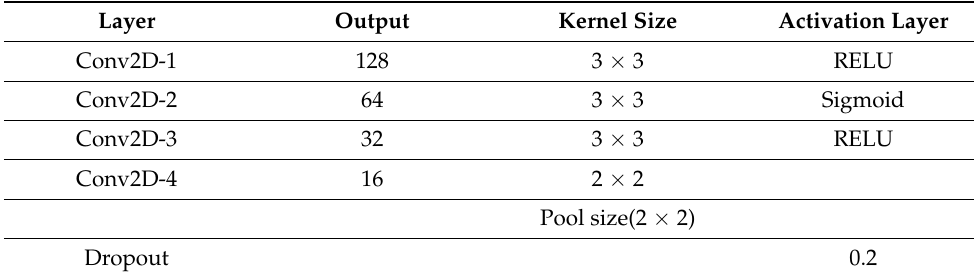
Table 2. Details of CNN